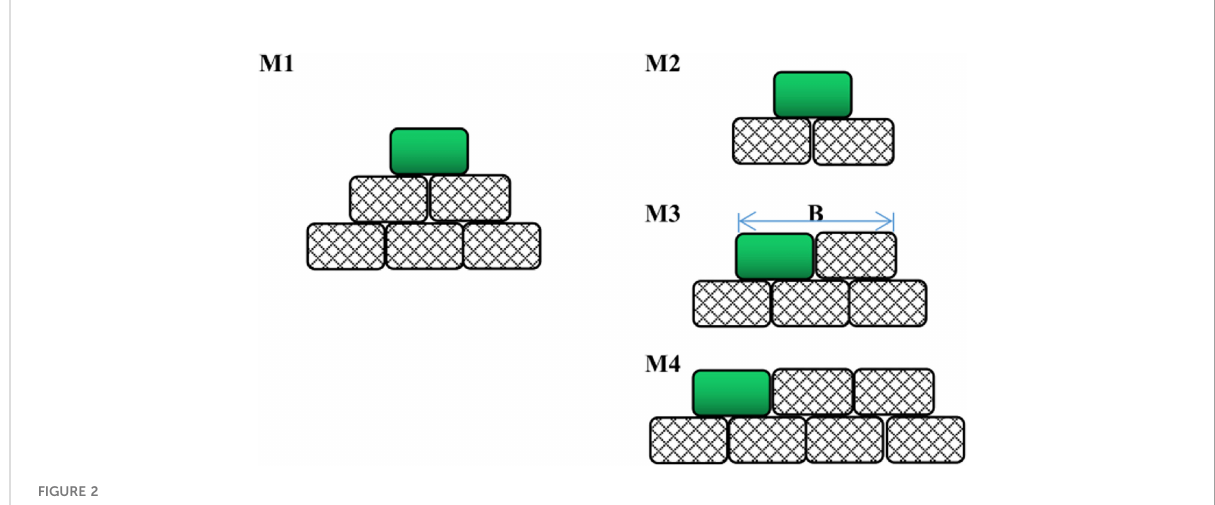
FIGURE 2 Oyster reef